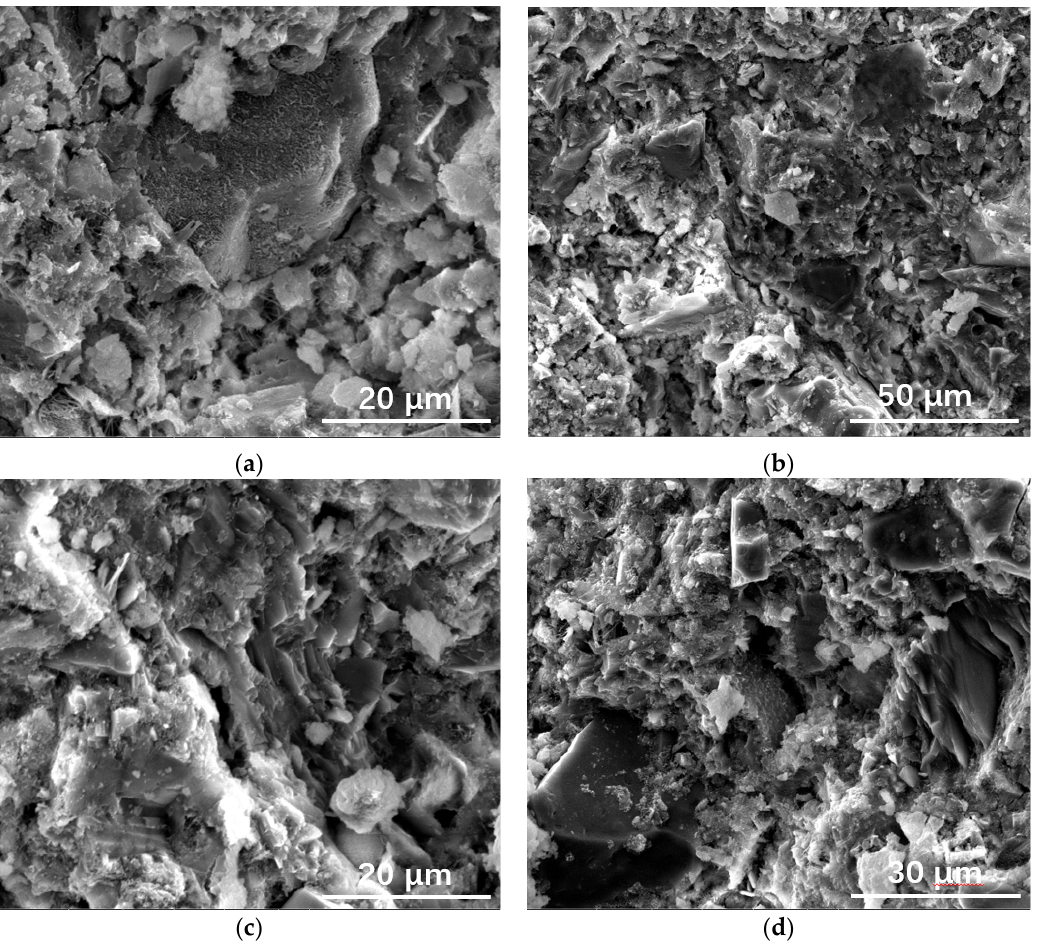
Figure 9. SEM images of samples: ( a ) 3_20 cured for 3 d; ( b ) 3_20 cured for 28 d; ( c ) 3_50 cured for 3 d; ( d ) 3_50 cured for 28